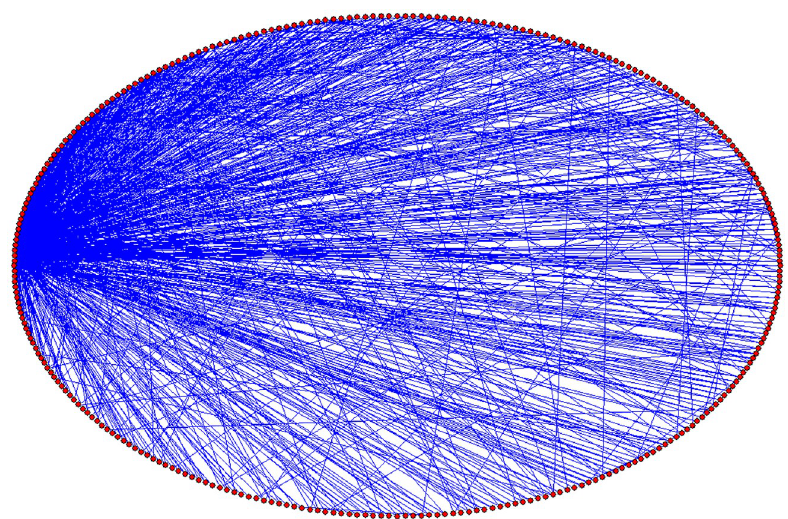
Fig 3. Topological diagram of the SFN. The red dots on the boundary of the ellipse represents 500 nodes, and the internal black line represents the connections between nodes.